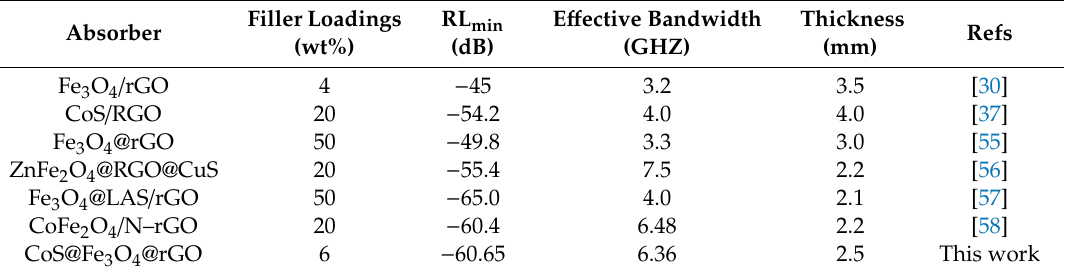
Figure 9. Reflection loss curves of S1 ( a ), S2 ( b ), and S3 ( c ); the effective absorption bandwidth of S2 ( d ). Table 1. A comparison of the electromagnetic wave (EMW) absorption capability with some previously reported ferrite–graphene-based